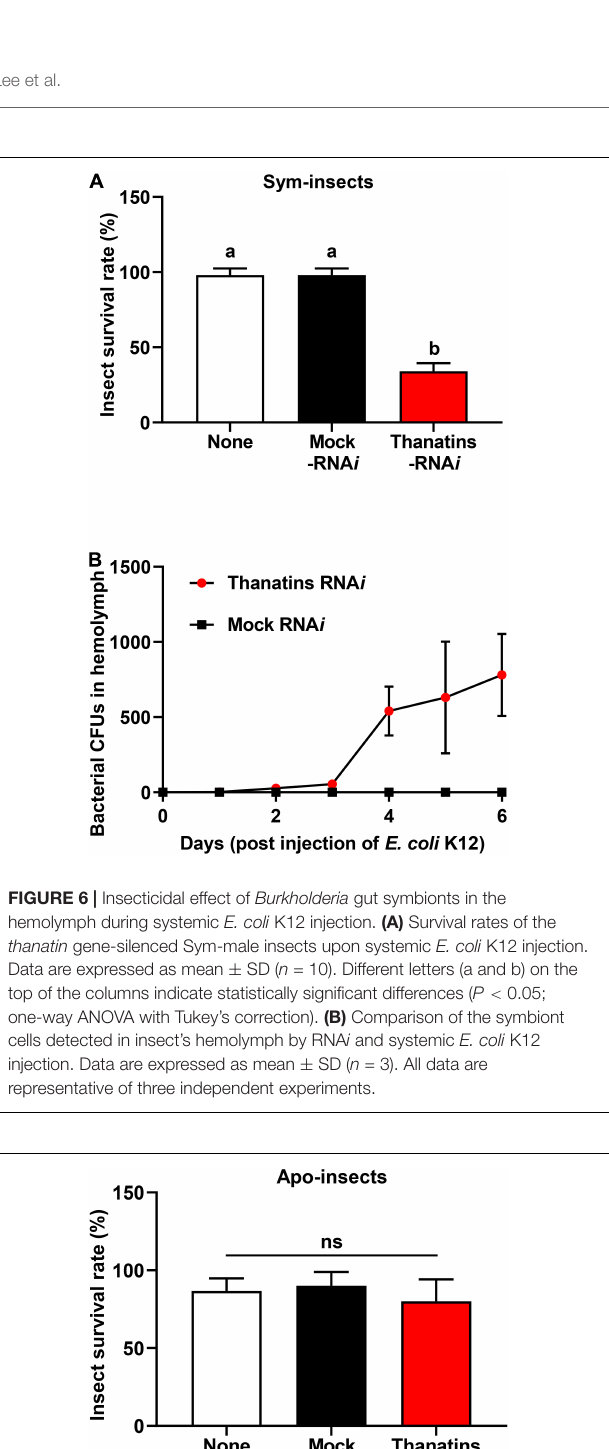
unclear. The peptide riptocin is derived from a precursor protein consisting of 678 amino acid residues with 14 tandem repeats (Miura et al., 1996). Each repeat contains a proline-rich region, which is also found in other insects (Levashina et al.,